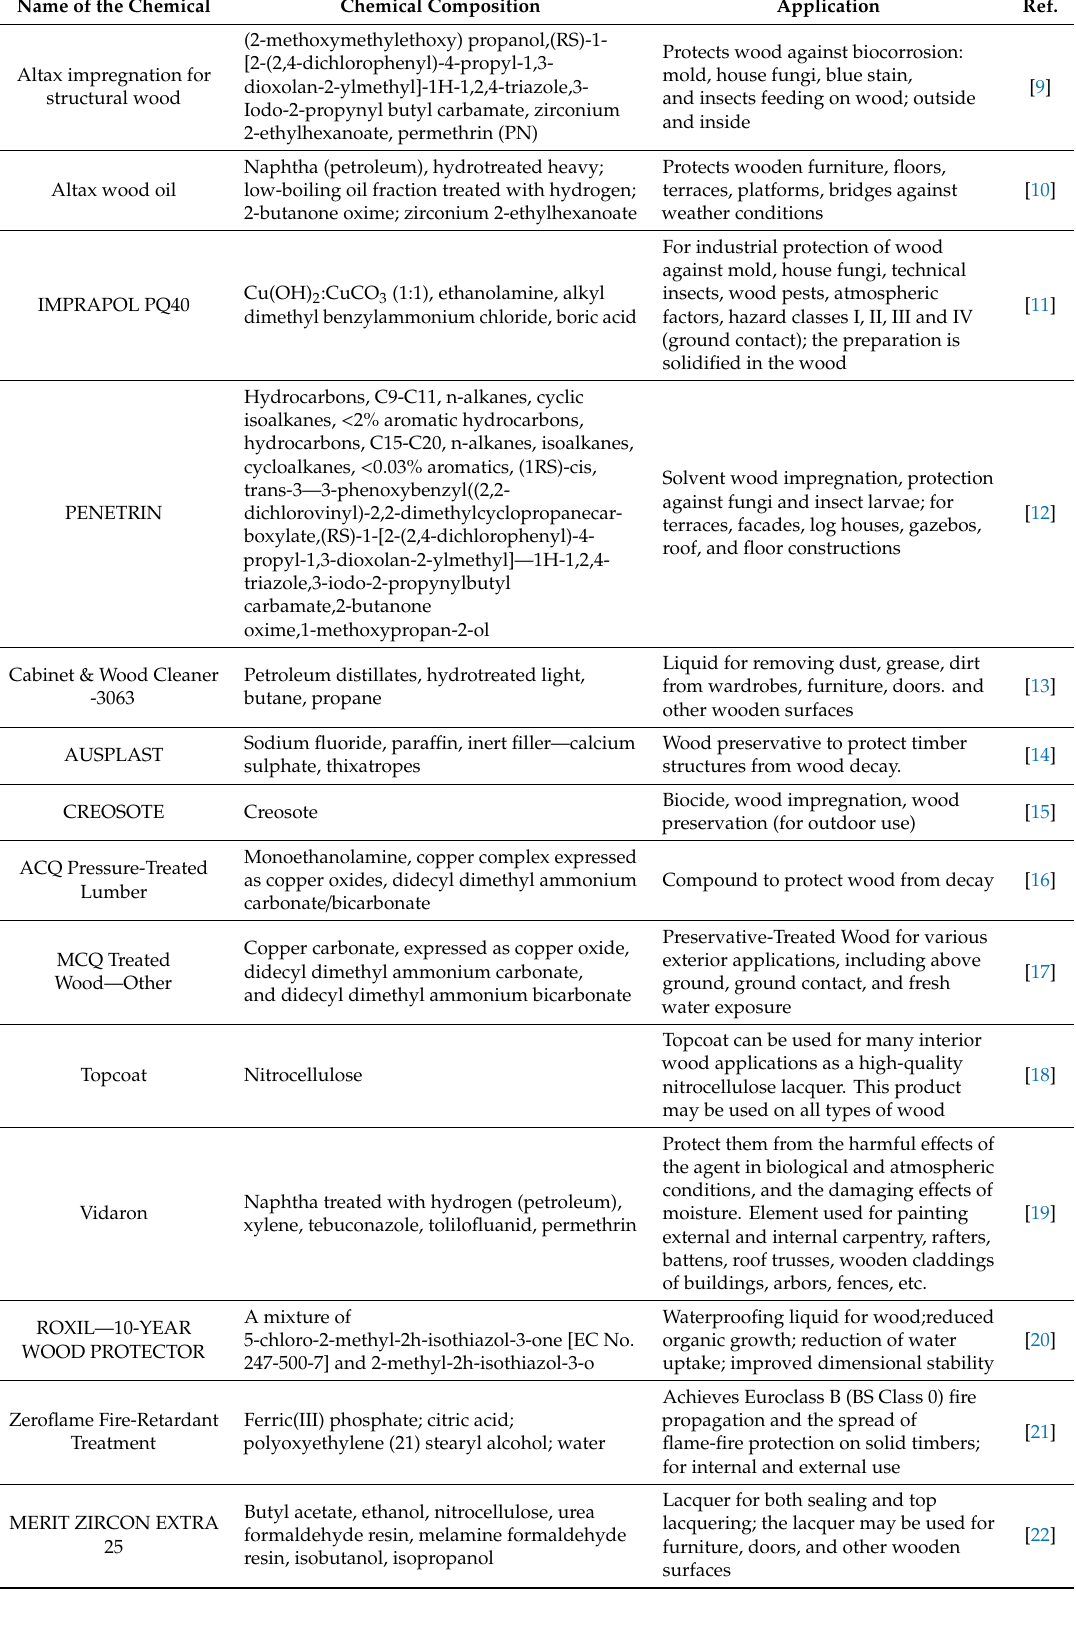
Table 1. Examples of chemical compounds used for wood / wooden products impregnation. Name of the